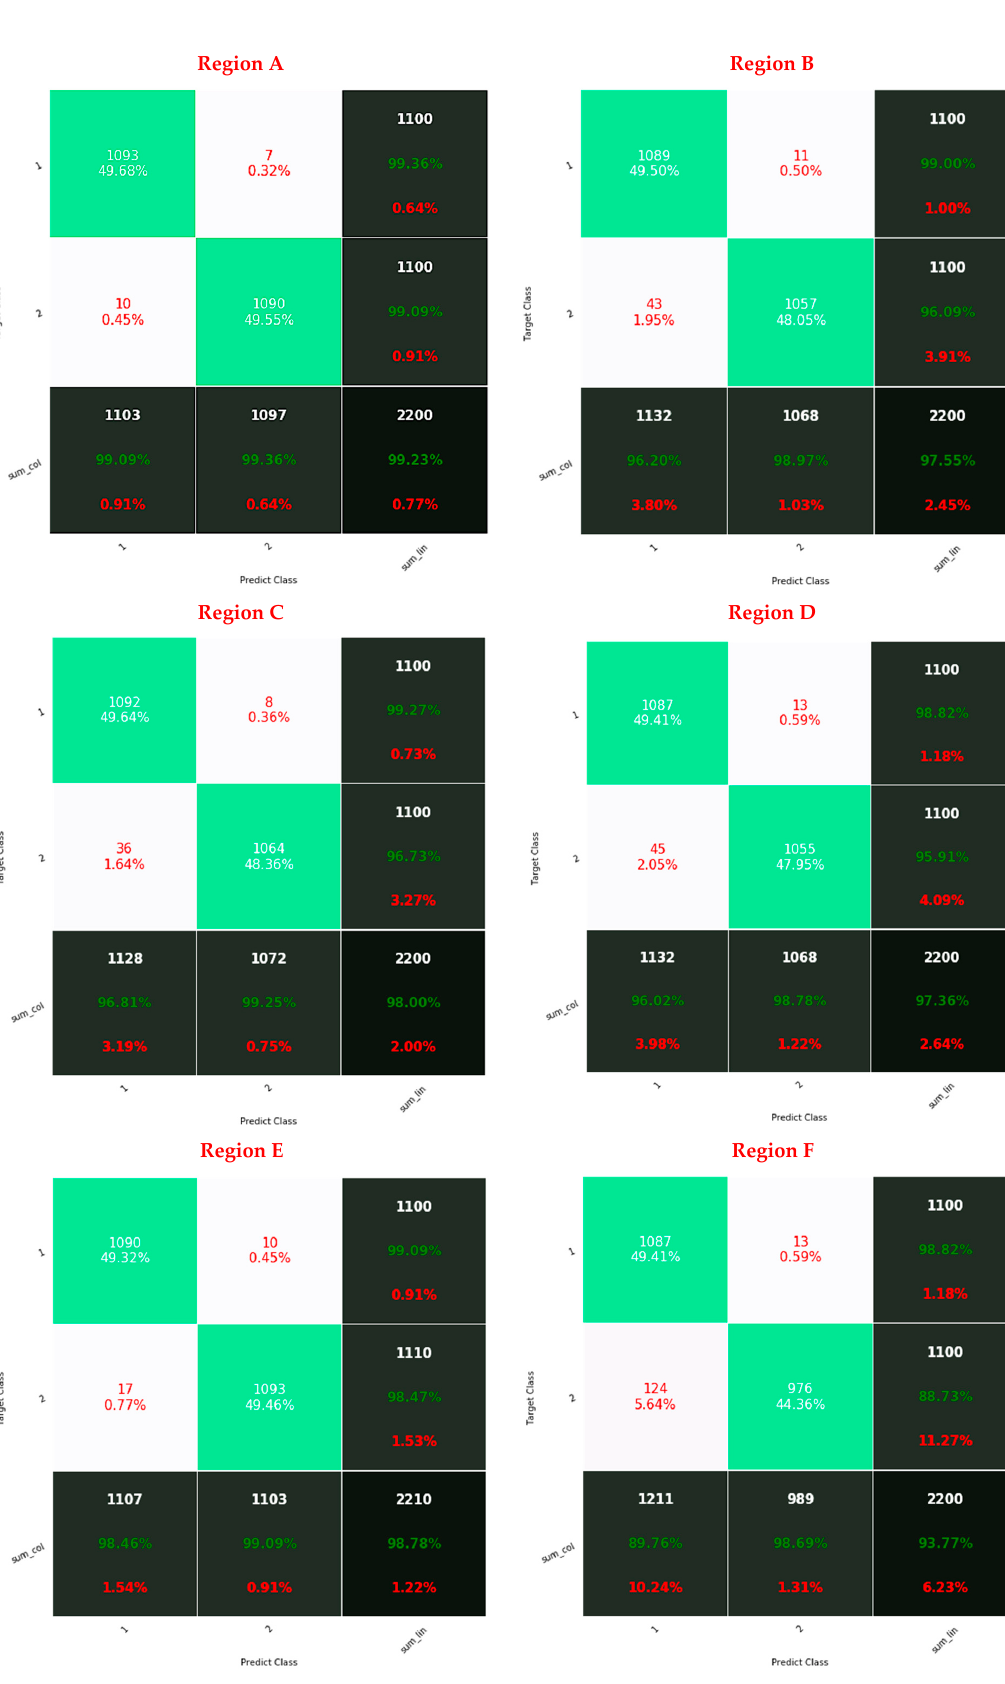
Figure 10. The confusion matrix for two-stage classification for regions A, B, C, D, E, and F.